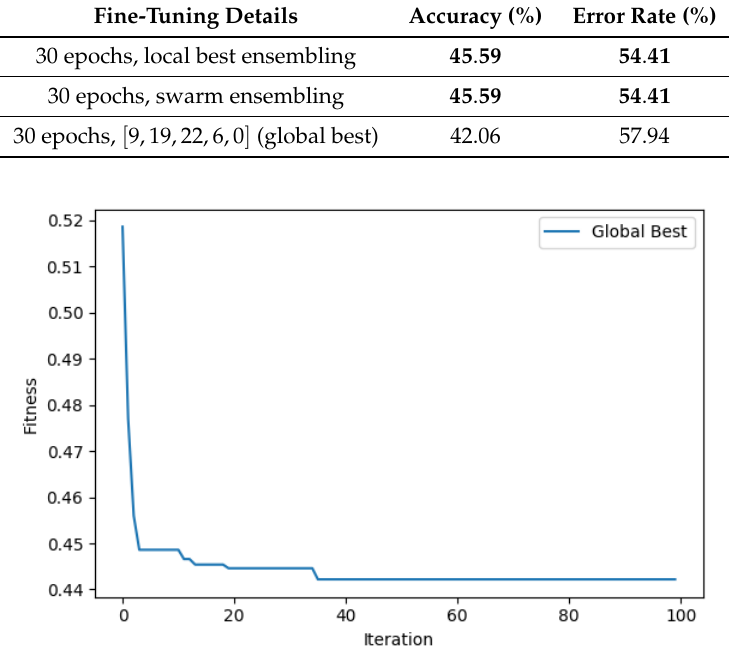
Figure 15. Fitness value of the global best particle throughout the optimisation process while using no weight inheritance